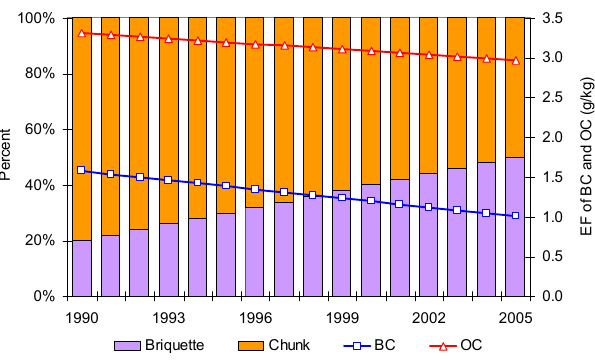
Fig. 3. Emission factors of BC (blue line) and OC (red line) de- clined as the share of briquettes in residential stoves